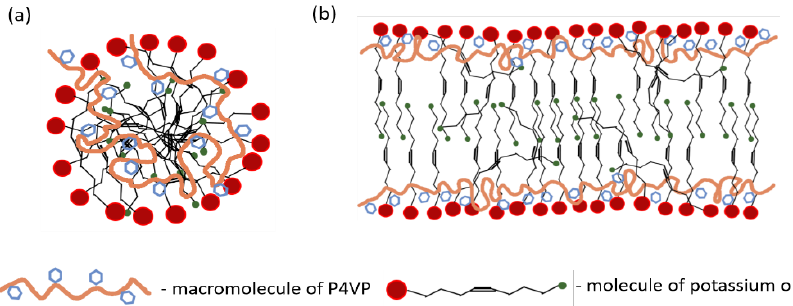
Figure 7. Schematic representation of the structure of the polymer-surfactant complexes formed by P4VP macromolecules (orange and blue) with spherical ( a ) and rodlike ( b ) micelles of potassium oleate (red, black and blue). The alkyl backbone and pyridinium rings of P4VP are shown in orange and blue, respectively. The headgroup, hydrophobic tail and terminal methyl group are shown in red, black and green, respectively.